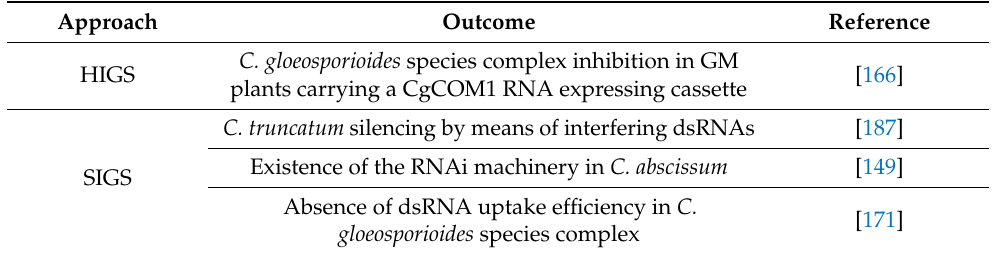
Table 4. Current investigations on the RNAi-based approaches for Colletotrichum